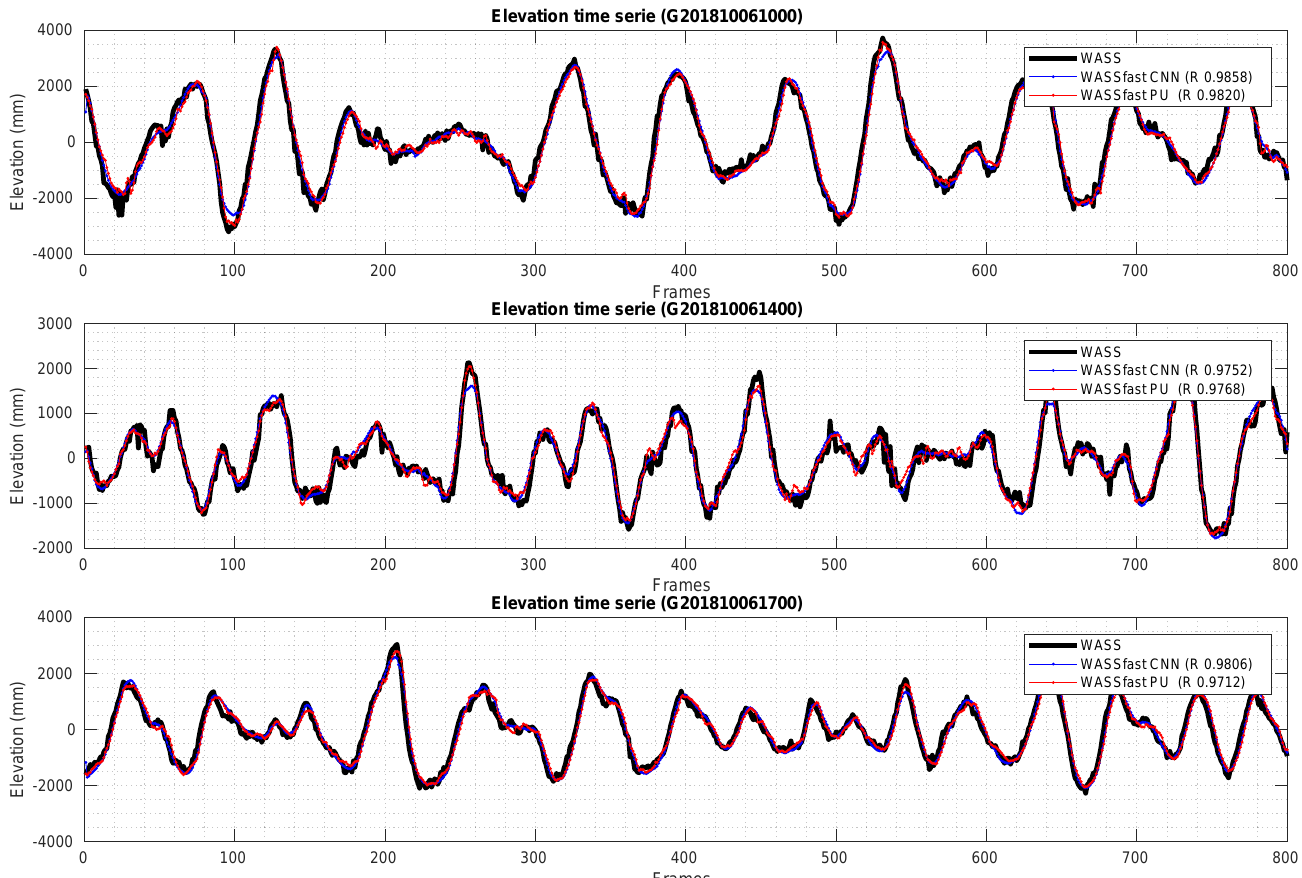
Figure 10. Time series comparison between WASS, WASSfast PU and WASSfast CNN on the three sequences at the Gageocho ORS. Pearson’s correlation between each WASSfast mode and standard WASS is reported in the